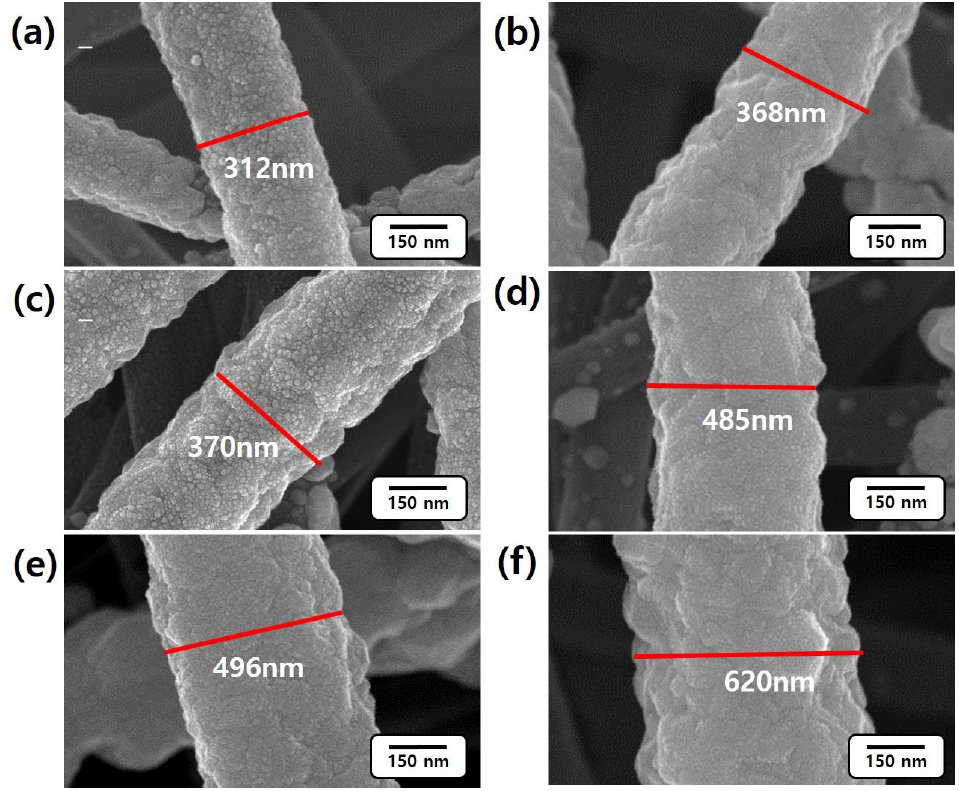
Figure 4. Magnified Pd/CNFs with different deposition time ( a , b ) 1 h; ( c , d ) 6 h; ( e , f ) 12 h is presented. The morphology changes are shown ( a , c , e ) before and ( b , d , f ) after hydrogen adsorption.